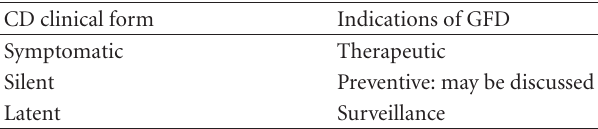
Table 6: Indications of GFD in CD of children and adolescents [75]. CD clinical